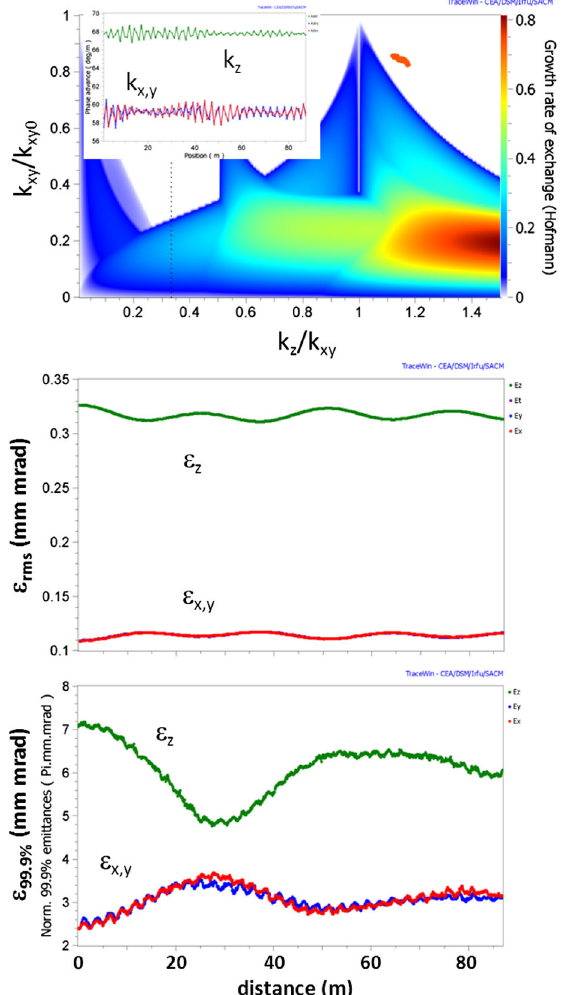
FIG. 7. Self-consistent evolution with k xy 0 ¼ 75 (cid:2) : tune foot- print on (zoomed) stability chart for (cid:2) z =(cid:2) x ¼ 3 (top, with graphs for k z and k x;y in the upper right corner); rms (center); and 99.9% (bottom) emittances.